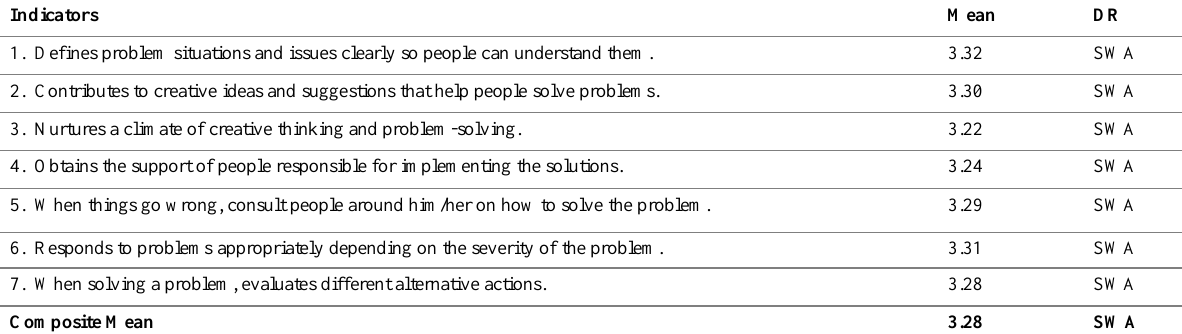
Table 3: The Leadership Skills of Administrators of Divine Word Colleges in the Ilocos Region in terms of Problem Solving Indicators